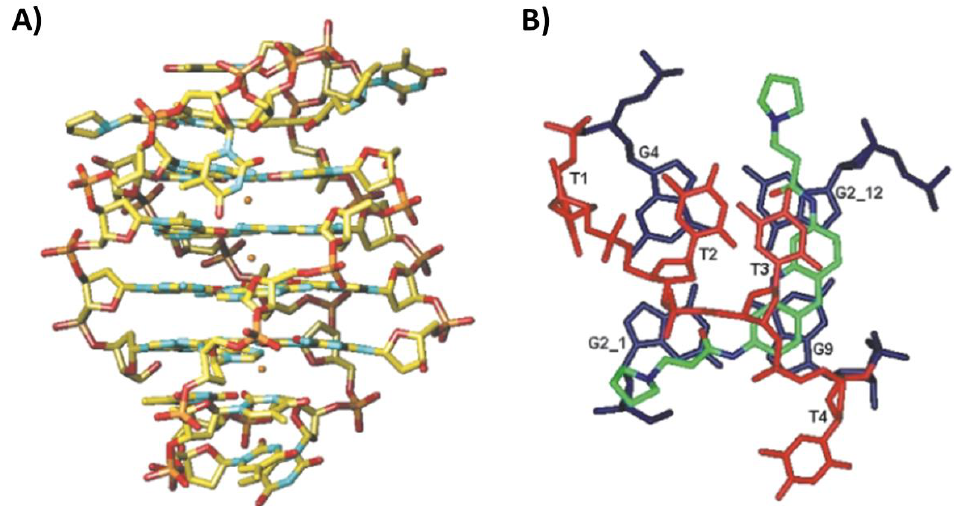
Figure 8. ( A ) Crystal structure of the complex between the bimolecular antiparallel G-quadruplex of o-tel12 sequence d(GGGGTTTTGGGG) and BSU6039. Details of the ligand binding are highlighted in ( B ). Adapted with permission from ref. [72], Copyright 2003 Elsevier Science Ltd.